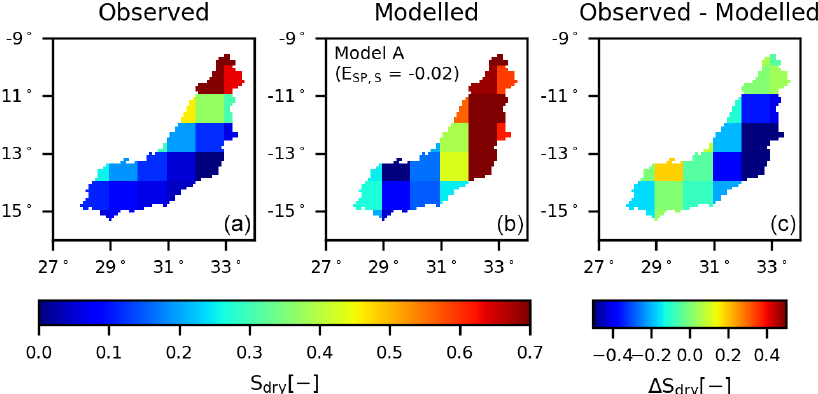
Figure 7. Spatial variability of the normalized total water storage anomalies for Model A averaged over all days within the dry season. Panel (a) shows the observation according to GRACE data, (b) the model result using the “optimal” parameter set with respect to dis- charge ( D E ,Q cal ) and (c) the difference between the observation and